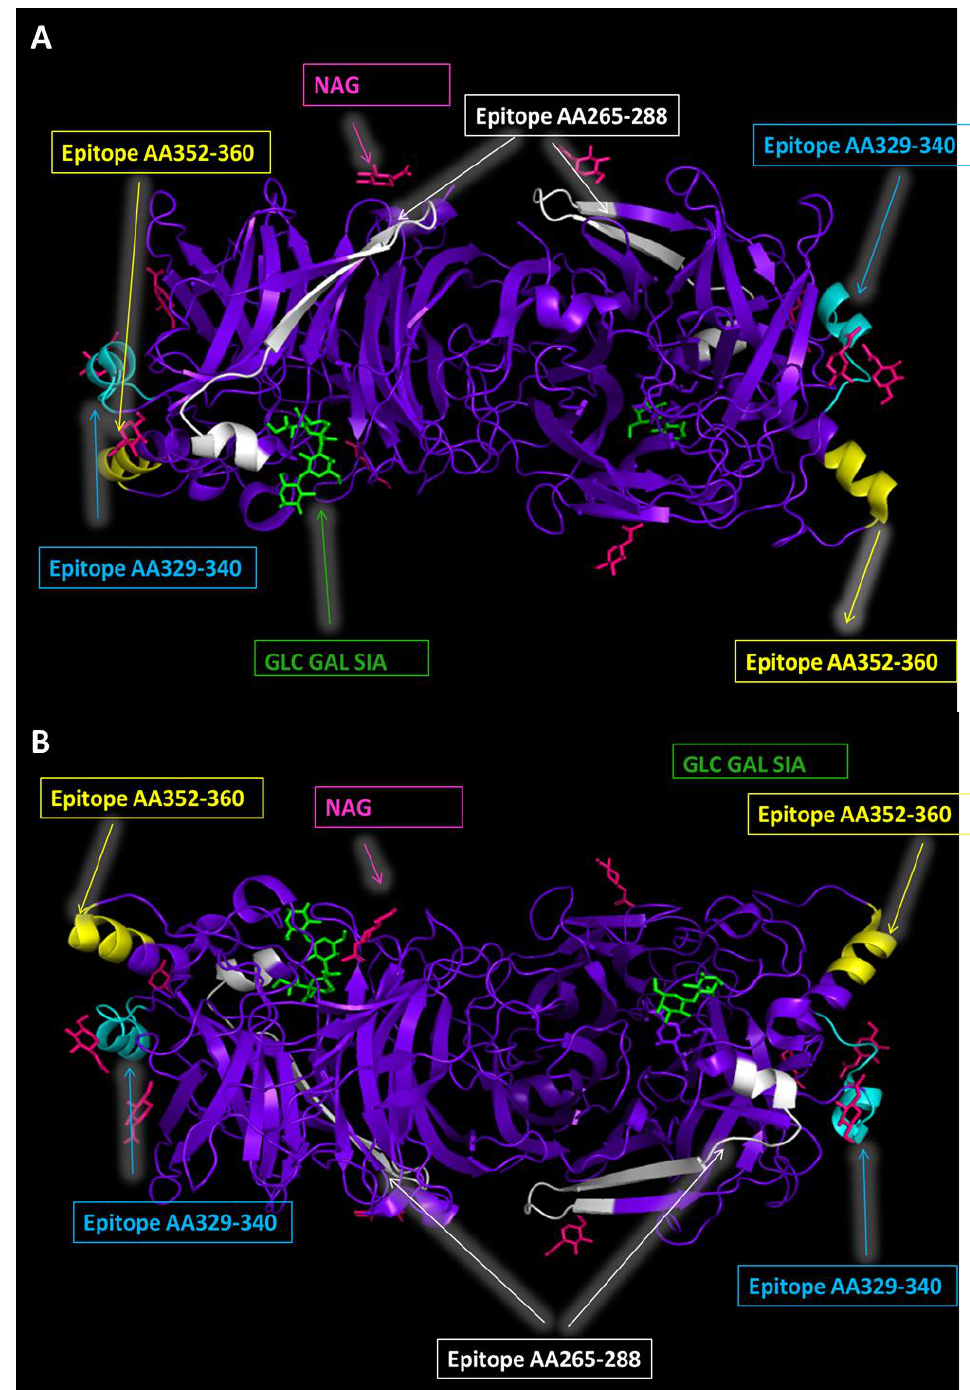
Figure 2. Protein structures generated from Protein Data Base file 5B2D [26]. ( A ) Protein binding sites and known epitopes of mumps HN protein (Front view). Protein binding sites and N-glycosylation sites of Mumps HN Protein (back view). Illustrated are the HN protein (purple), N-acetyl-D-glucosamine binding sites (pink), and sialic acid receptor binding sites (green). Different epitope locations are labelled with arrows and boxes indicate the amino acid range. ( B ) Protein binding sites and known epitopes of mumps HN protein (back view). Protein binding sites and N-glycosylation sites of mumps HN Protein (back view). Illustrated are the HN protein (purple), N-acetyl-D-glucosamine binding sites (pink), and sialic acid receptor binding sites (green). Different epitope locations are labelled with arrows and boxes indicate the amino acid range.